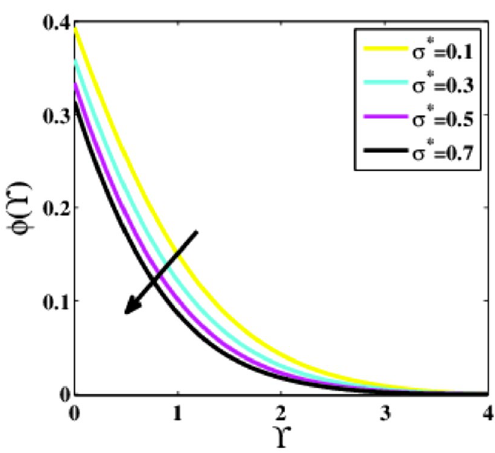
Figure 23. Plots of φ(ϒ) for σ